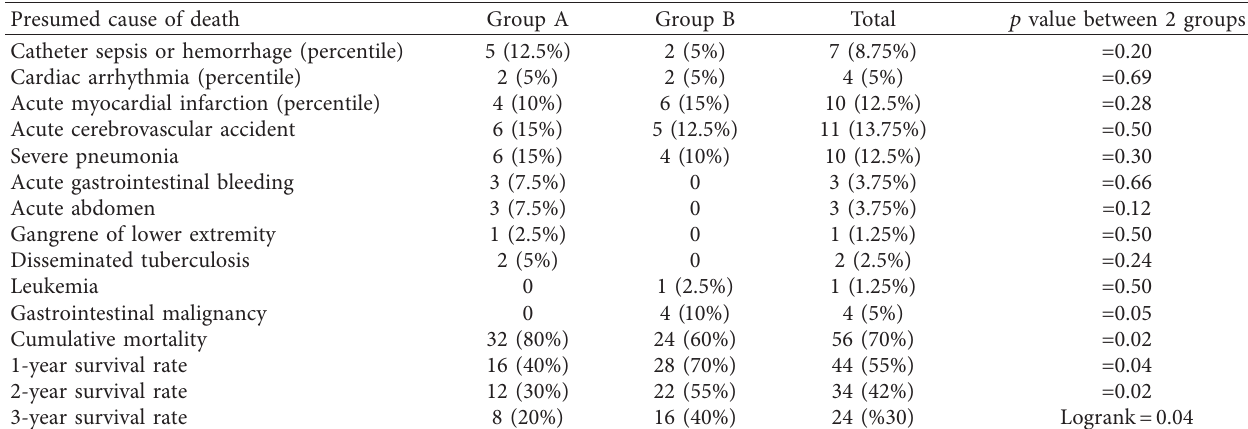
Table 3: Cause of death and survival rate in two groups from 2012 to